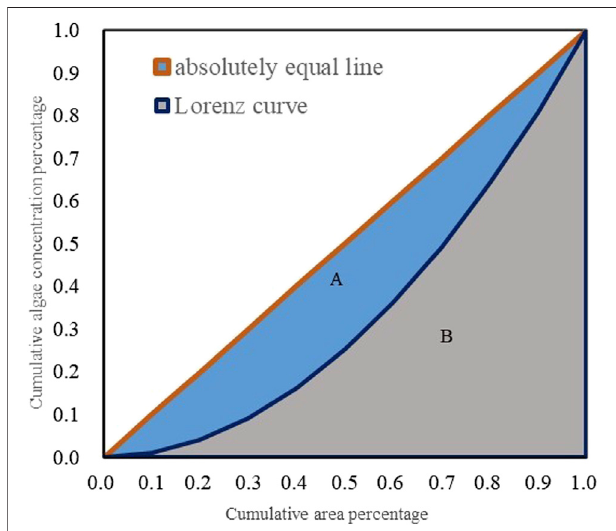
FIGURE 4 | Sketch of the Lorenz curve and Gini coef fi cient.